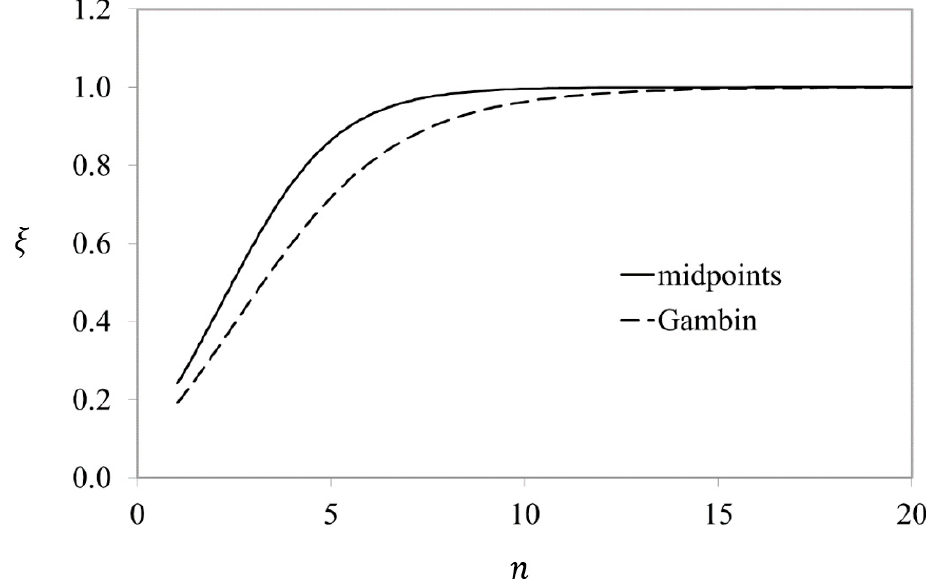
Figure 1. Fitted coefficient of the yield surface as function of the exponent 𝑛 , for the case of fcc with octahedral slip systems, fitted to facet midpoints and by the regularization proposed by Gambin (1992), [5].